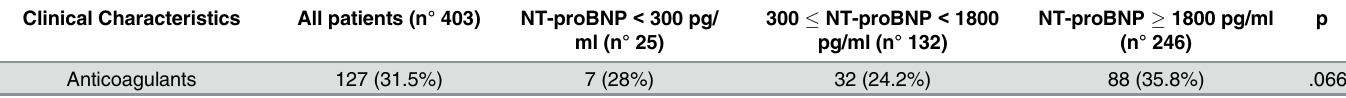
ues at univariate analysis with a p < .10 were included in a logistic regression model (for the dichotomic variable HF) and in a multiple linear regression model (for ln-transformed NT- proBNP) to test their independent association and their relevance. Data are shown in Tables 2 and 3. Estimated-GFR and atrial fibrillation showed the better relation with NT-proBNP, fol- lowed by polypharmacy, CRP, albumin and age.